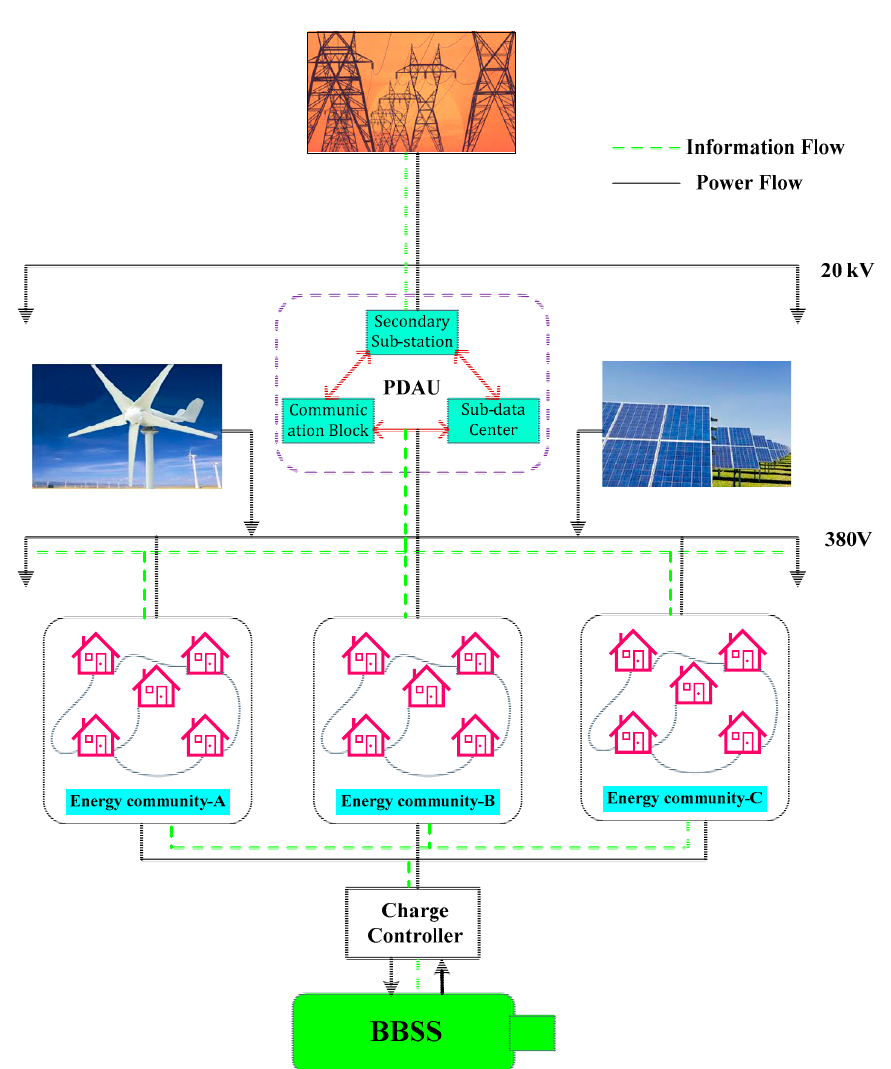
Figure 1. Proposed community-based smart grid architecture.